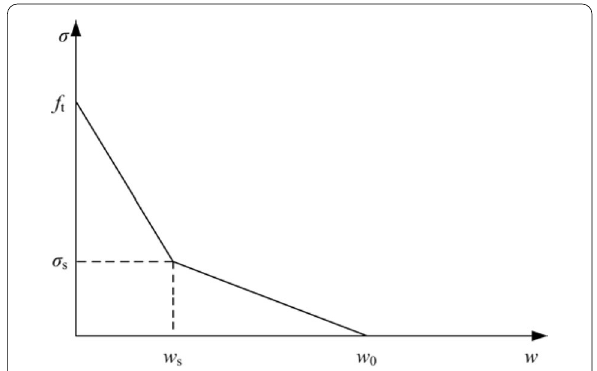
Fig. 12 Bilinear softening traction–separation